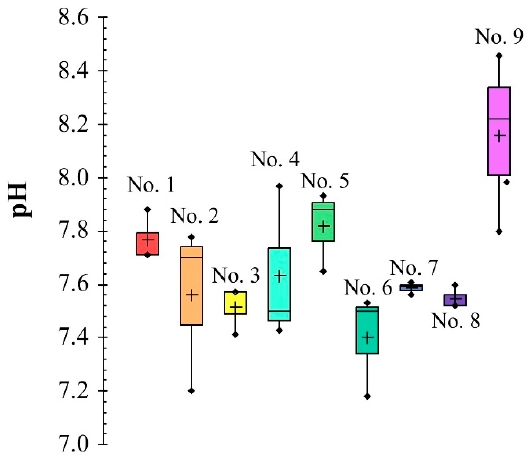
Figure 4. Boxplots showing the median, quartiles, and minimum and maximum values of pH for samples collected from the road drainage systems. samples collected from the road drainage